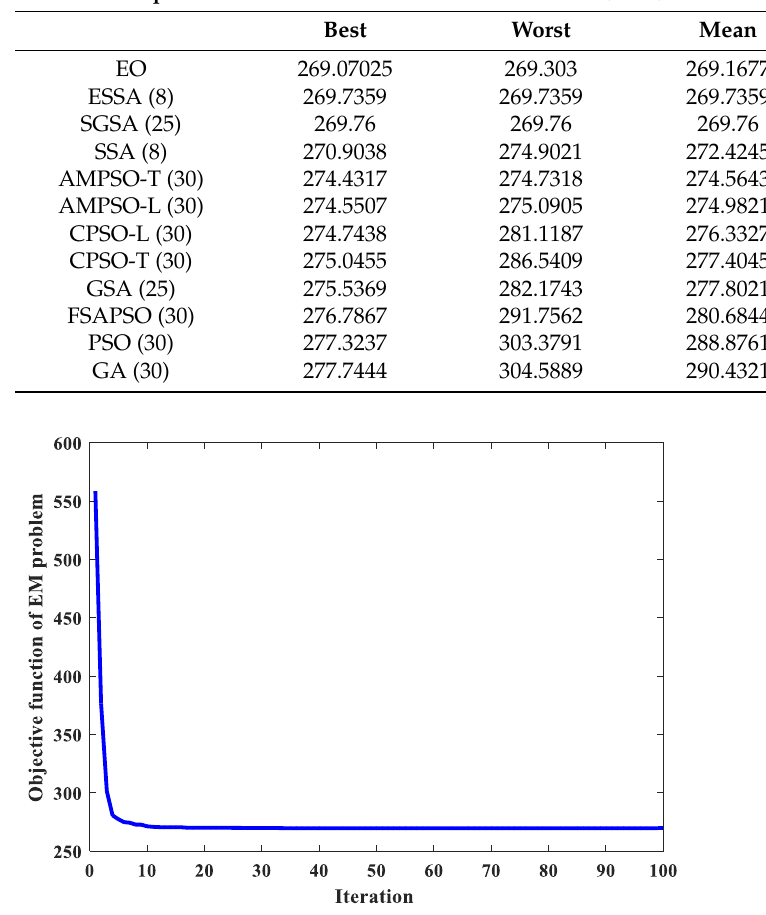
Figure 4. Convergence characteristic of EO for Case 1. Table 2. The best results obtained using EO for the energy management (EM) problem (Case 1).